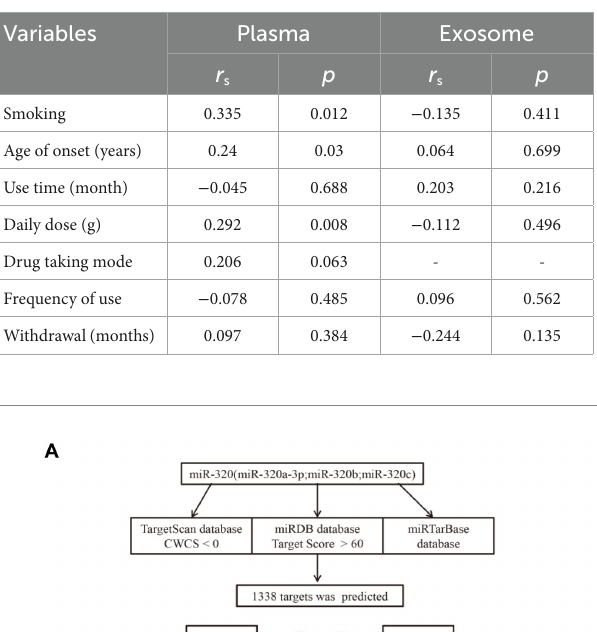
TABLE 4 Correlation analysis between miR-320 expression level in MA disorder group.